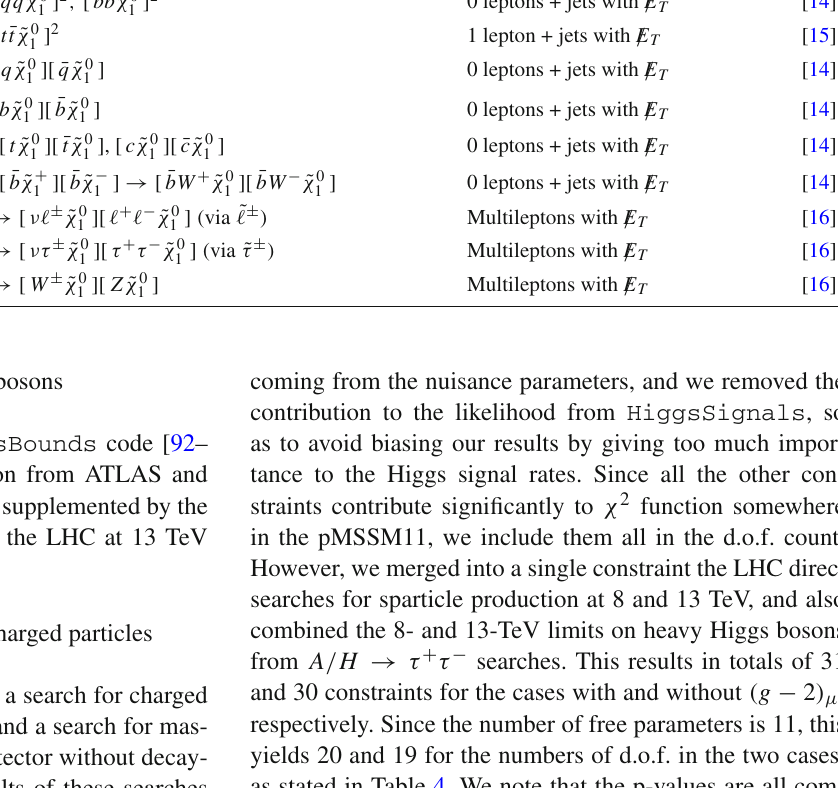
Table 3 Summary of the simplified model limits from ∼ 36/fb of CMS data at 13 TeV used in our study